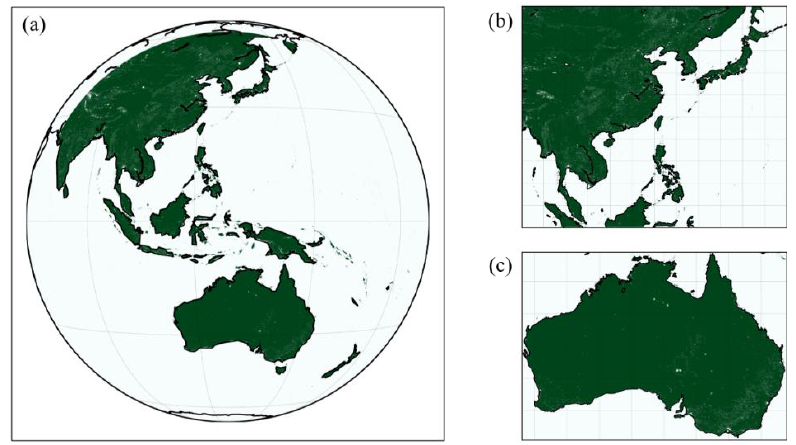
Figure 1. ( a ) Study area used for obtaining soil moisture coefficients. Validation areas of ( b ) East Asia and ( c ) Australia.